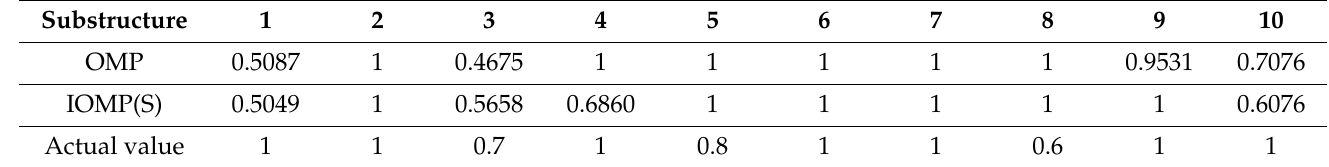
Table 1. Identification results of OMP and IOMP(S) method with nonlinearity iteration. Substructure